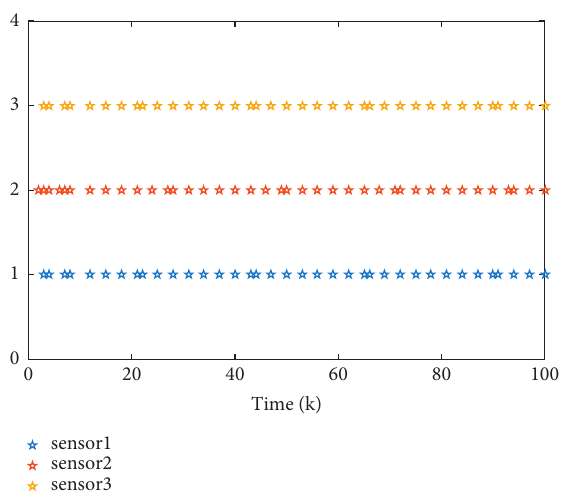
Figure 6: Static triggering